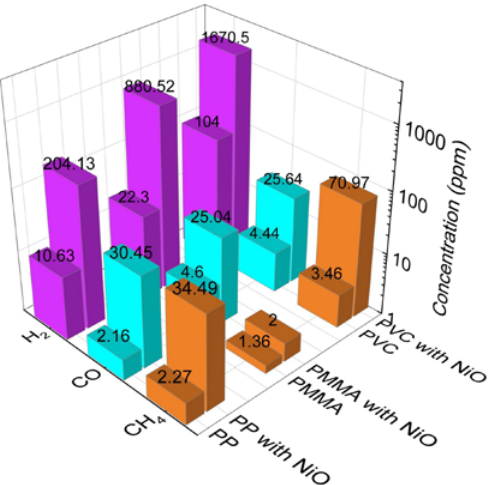
Figure 4. The production of flammable gases after 24 h magnetic stirring for PP, PMMA, and PVC reactors. For every reactor, two experiments were conducted in which no NiO particles and 1.00 g of NiO particles were added to the deionized water, separately.